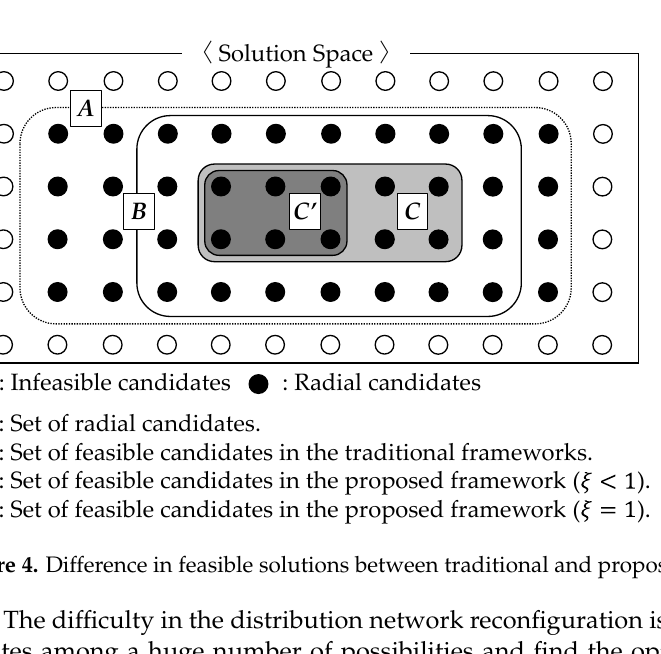
Figure 4. Difference in feasible solutions between traditional and proposed frameworks.